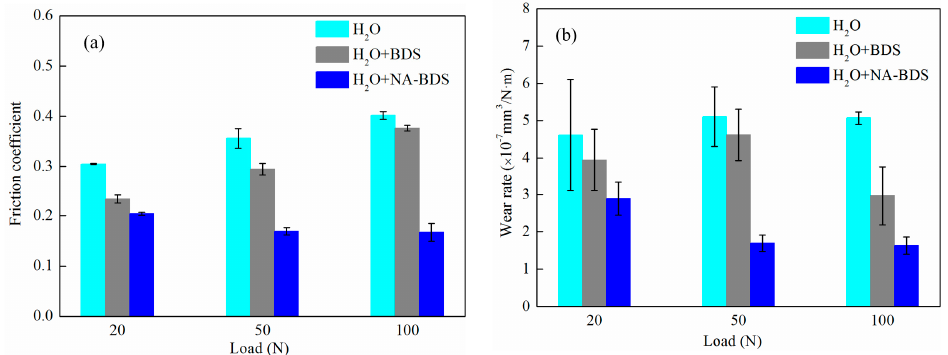
Figure 7. Evolutions of the ( a ) average friction coefficient and ( b ) wear rates for lubrication using BDS and NA-BDS in H 2 O at different loads (soot content = 0.2 wt %, speed = 50 mm/s, duration = 30 min).